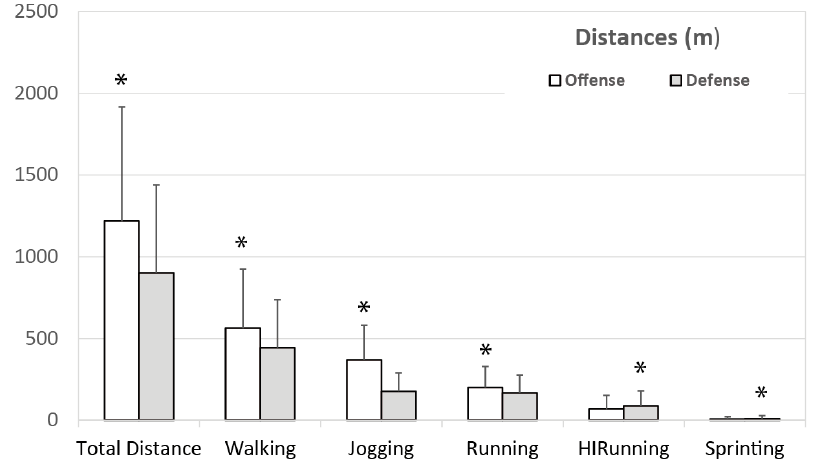
Figure 3. Distance covered in each locomotion category by offense and defense. * Significant differences between offense and defense ( p < 0.05).